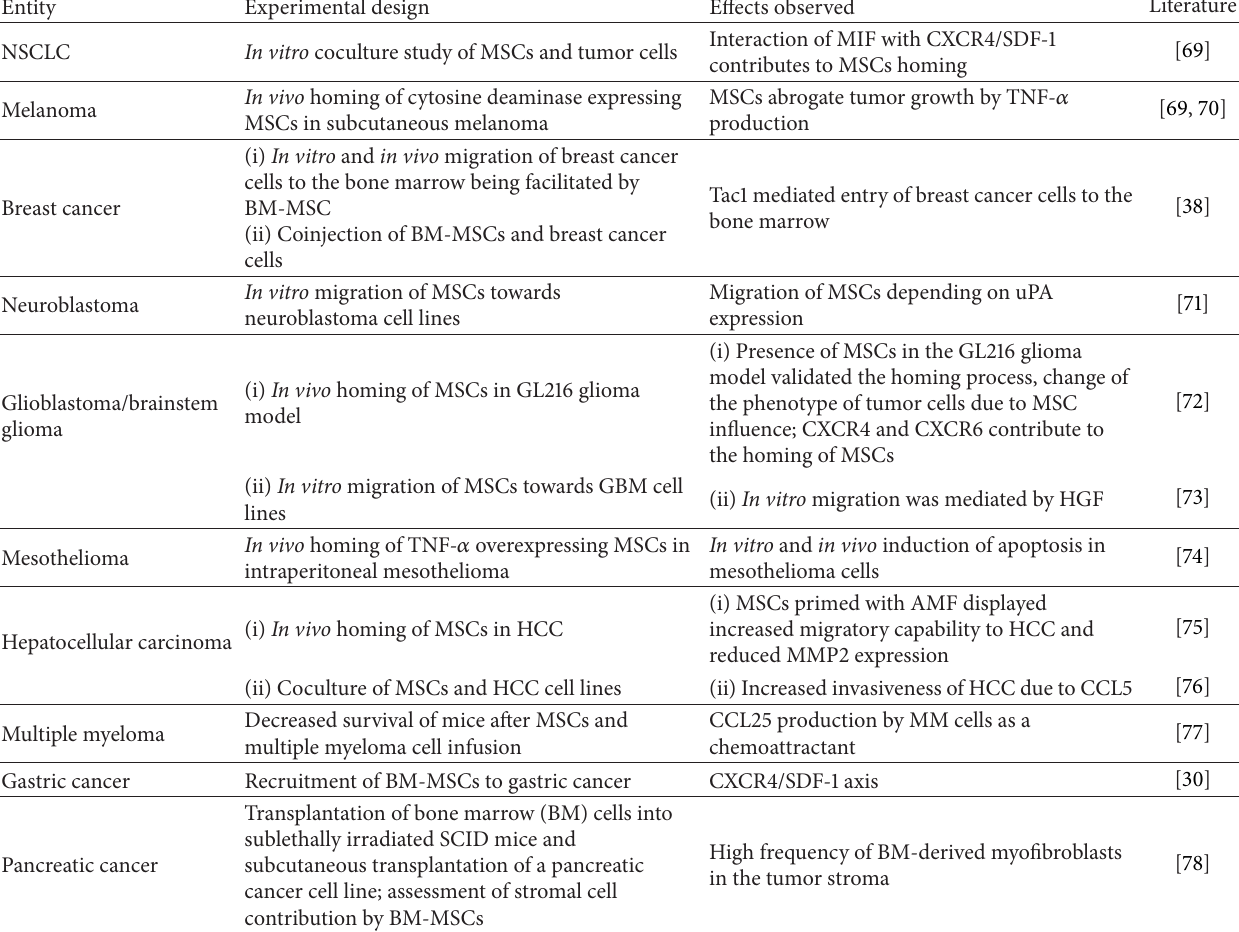
Table 4: Overview on homing mechanisms of MSCs and MSC effect on tumor